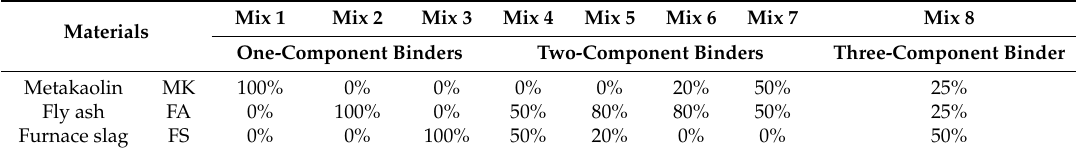
Table 2. Design parameters of alkali-activated binders for mortars development (all the percentages are intended by